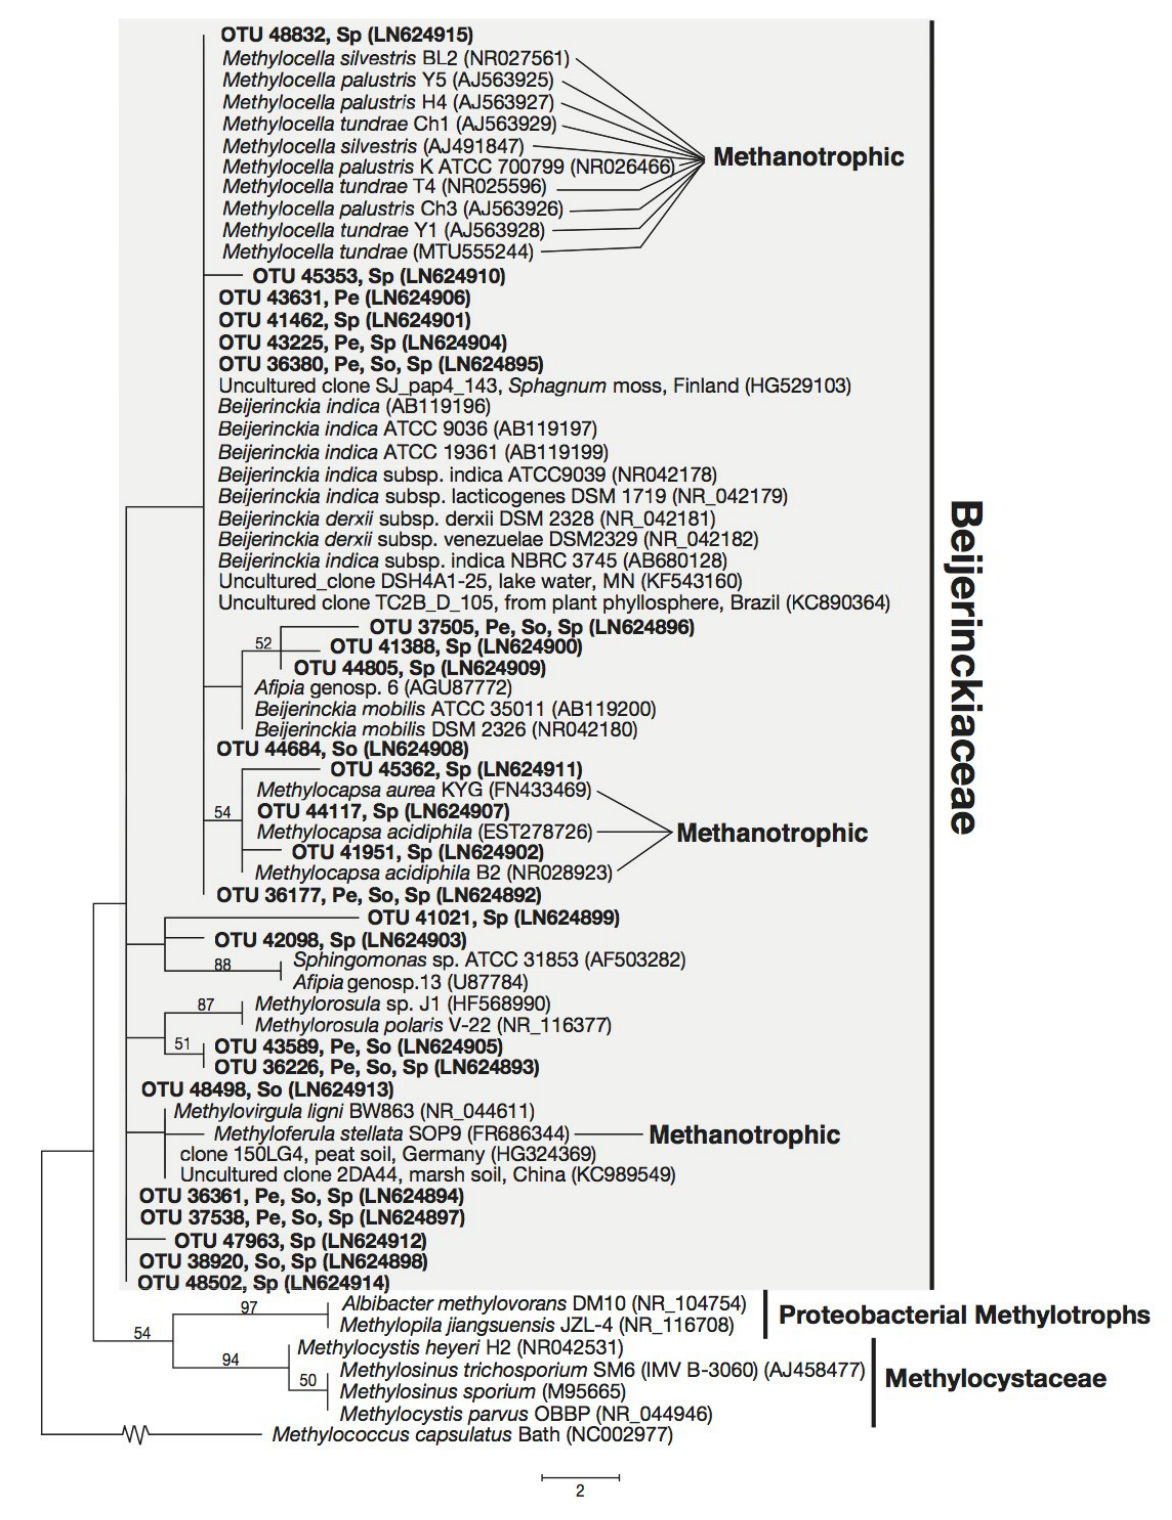
Figure 3. Phylogenetic tree based on maximum parsimony (MP) analysis of twenty-four OTUs (~169 bp) detected in this study (in bold) in comparison with their close relatives and methanotrophic representatives from the Beijerinckiaceae. The locations where these OTUs were detected are indicated: Pe, peat; So, forest soil; Sp, Sphagnum moss. Bootstrap values from 1000 replicates are indicated at the nodes of branches (if > 50). The scale bar represents the number of nucleotide